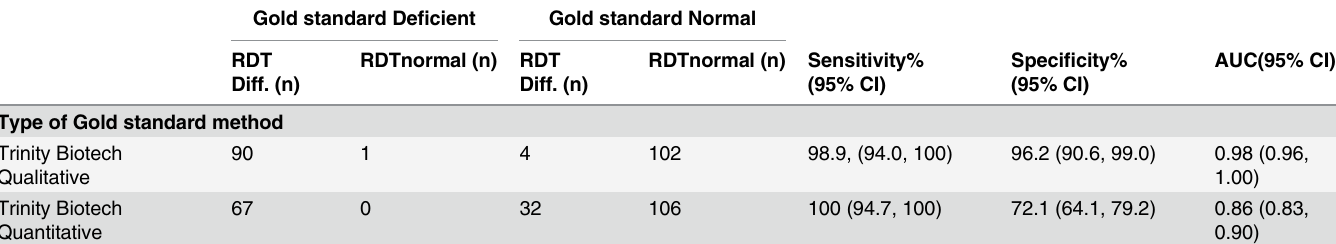
Table 2. Performance of the CareStart G6PD deficiency RDT kit to other commercially available methods for screening G6PD deficiency .